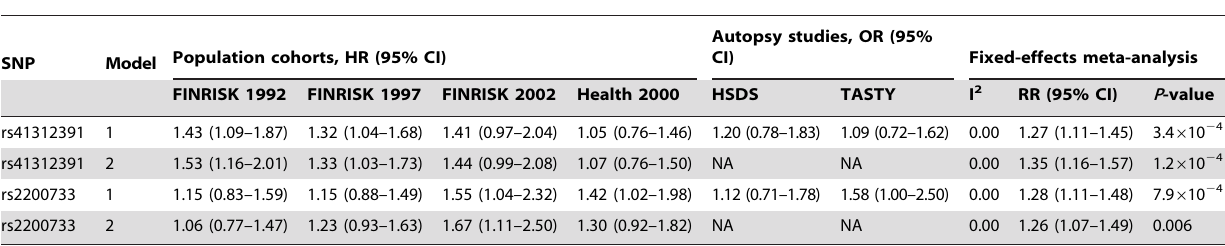
Model 1: Age was used as the time scale and sex and geographic region were adjusted for. Model 2: Sex, geographic region, HDL-total cholesterol ratio, systolic blood pressure, prevalent diabetes, BMI, current and former smoking status, physical activity, and prevalent CHD were adjusted for. BMI = body mass index, CHD = coronary heart disease, CI = confidence interval, HDL = high-density lipoprotein cholesterol, HR = hazard ratio (in Cox regression), HSDS = The Helsinki Sudden Death Study, I 2 = measure of heterogeneity between studies, OR = odds ratio (in logistic regression), RR = relative risk, SCD = sudden cardiac death, SNP = single nucleotide polymorphism, TASTY = The Tampere Autopsy Study.